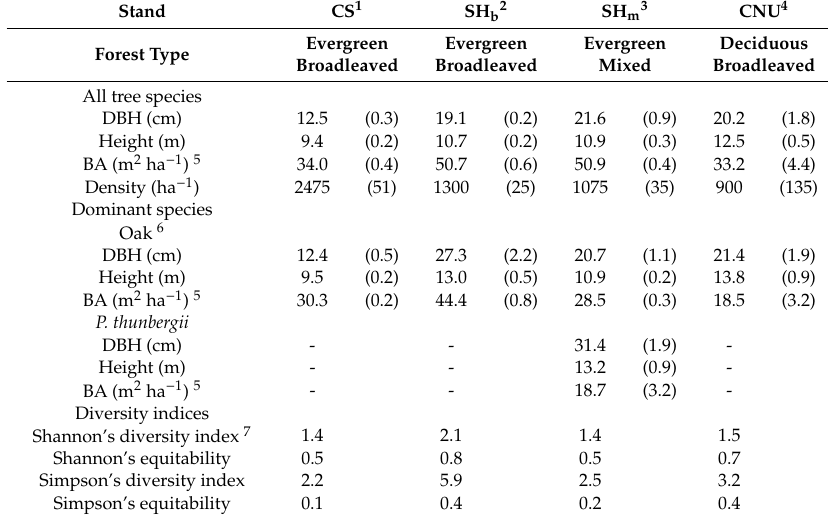
Table 1. Descriptions of four study stands in Jeju Island (CS, SH b , and SH m ) and Daejeon (CNU) in